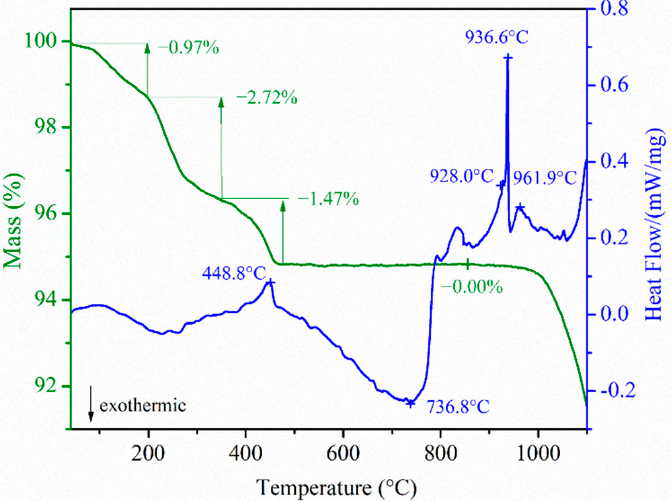
Figure 1. Combined thermogravimetric (TGA) and differential scanning calorimetry (DSC) results obtained on as-milled Bi 2 O 3 and Fe 2 O 3 mixture.